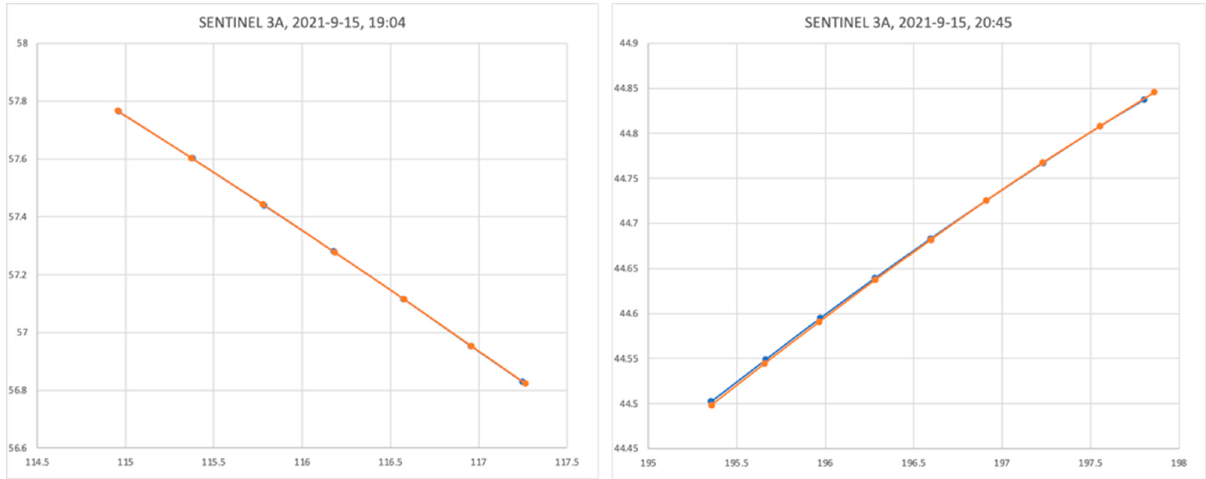
Figure 25. Two passes of the Sentinel 3A satellite. The ground truth is shown in blue, and the measurement in orange.